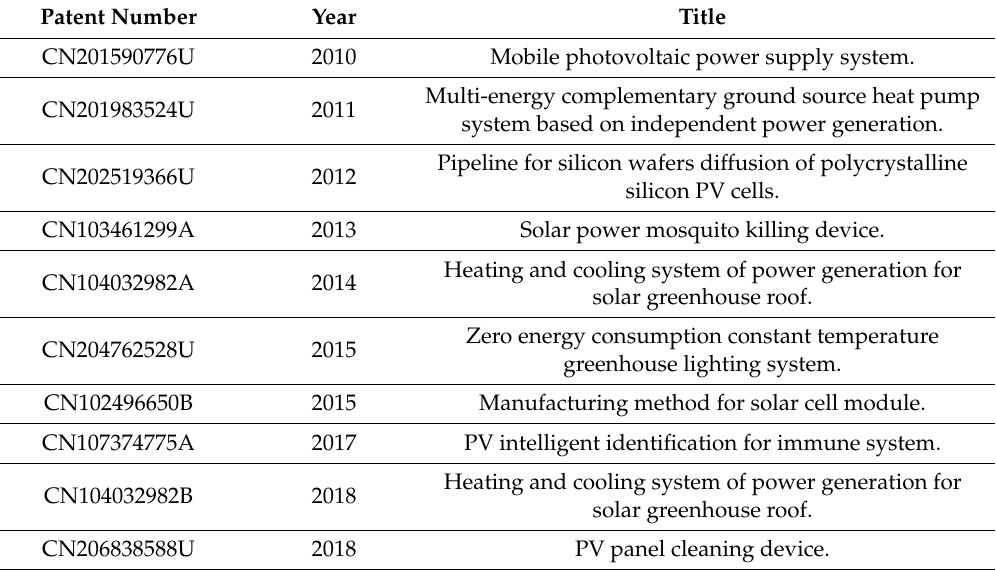
Table 4. Doc2vec output for Case